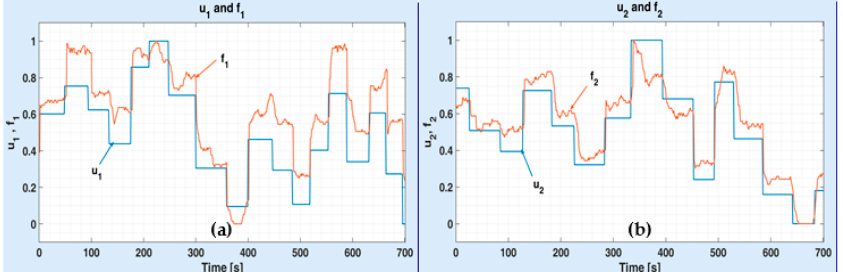
Figure 7. Test input prs to detect transient dynamics of inflows feeding the ASTANK2 main tanks on: channel 1 ( a ) and channel 2 ( b ).